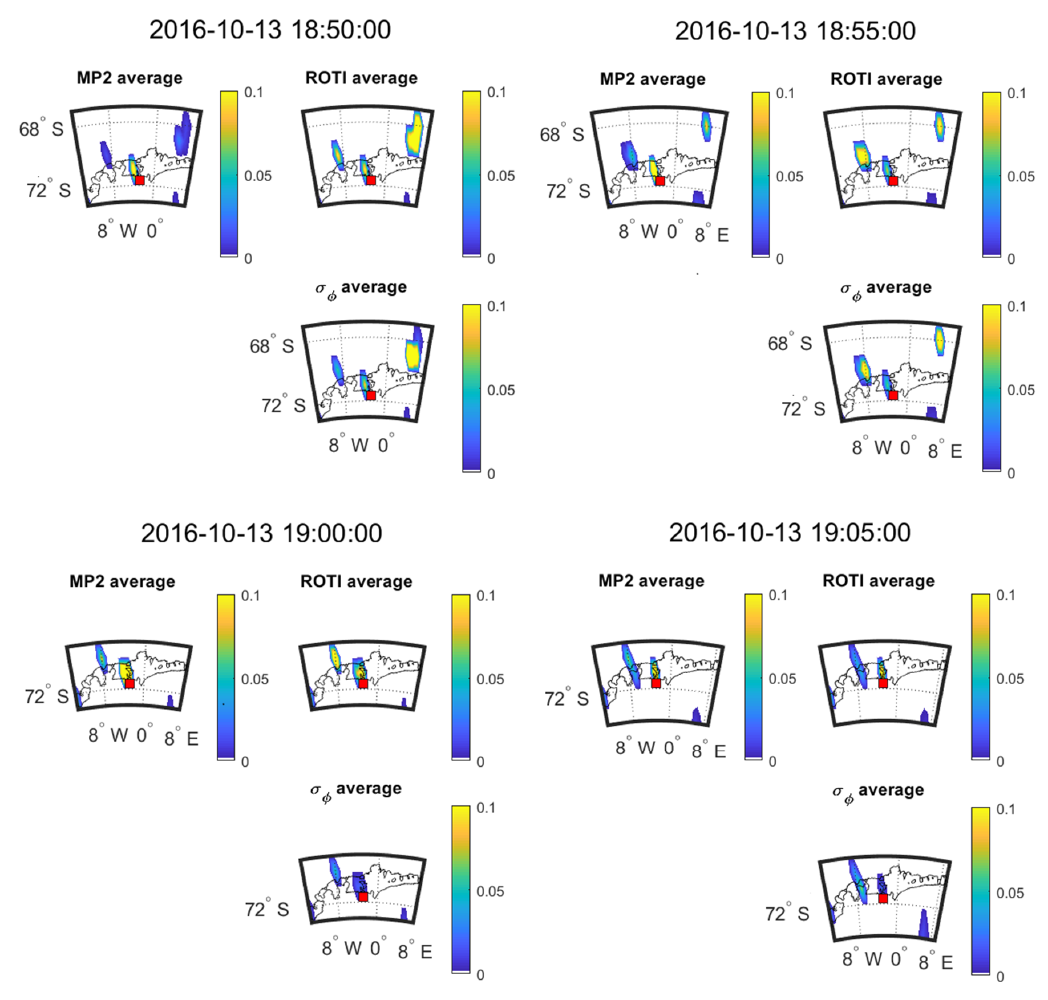
Figure 18. Consecutive 5 min means over 20 min at SNA0P station on 13 October 2016. Table 21. SSIM and CC between the maps shown in Figure 17.